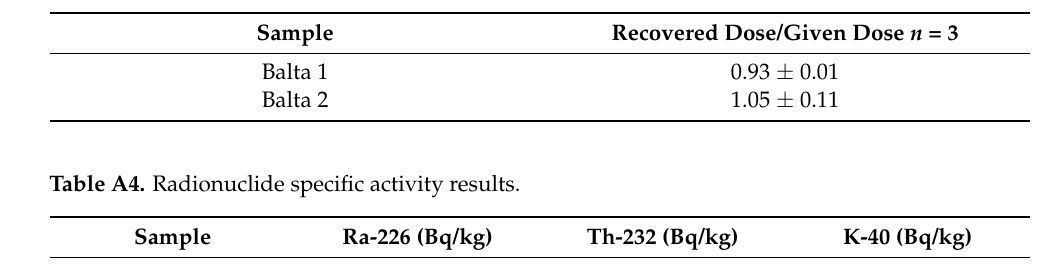
Figure A3. Preheat plateau for Balta 1 fine grains. Table A3. Dose recovery tests results-fine grains. Given dose 533 Gy for Balta 1. Given dose 402 Gy for Balta 2.